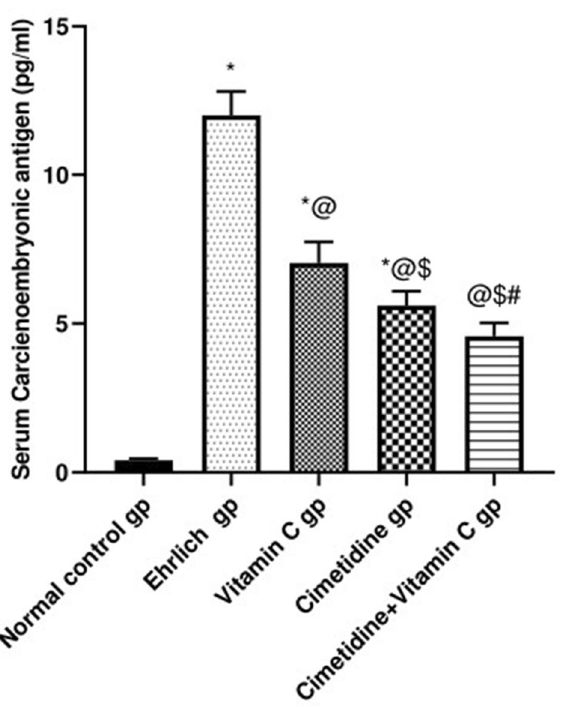
Figure 4. Changes in the serum CEA concentration following treatment with cimetidine at a dose of 200 mg/ kg/day, vitamin C at a dose of 4 g/kg/day, and their combination for 15 days after Ehrlich induction of breast cancer in mice. Data are presented as mean ± SD.* Significantly different from the normal control group, P < 0.05. @ is significantly different from Ehrlich untreated group, P < 0.05. $ is significantly different from the vitamin C- treated group, P < 0.05. # is significantly different from the cimetidine-treated group, P <